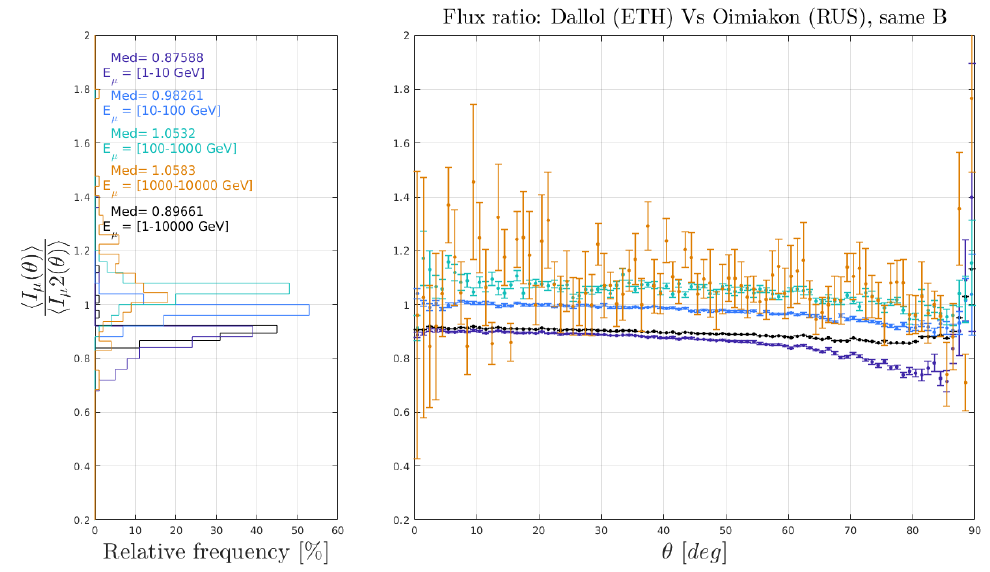
Figure 12. ( Left panel ) Histogram of flux ratio values computed over the zenith angle range (details are shown in the right figure) for several energies range from 1 to 10,000 GeV (in color) and for the whole energy range (in black). ( Right panel ) Flux ratio as a function of the zenith angle theta of two extreme temperature atmosphere for the same energy ranges as left panel. The different atmosphere conditions are (1) Dallol (Ethiopia) (2) Oimiakon (Russia), 12/30/20, with constant geomagnetic field and altitude. The latter is the reference flux (ratio denominator). Med corresponds to the median value in each energy range.